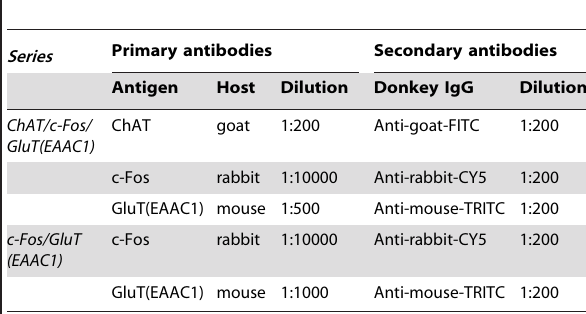
Table 1. Combination of primary and secondary